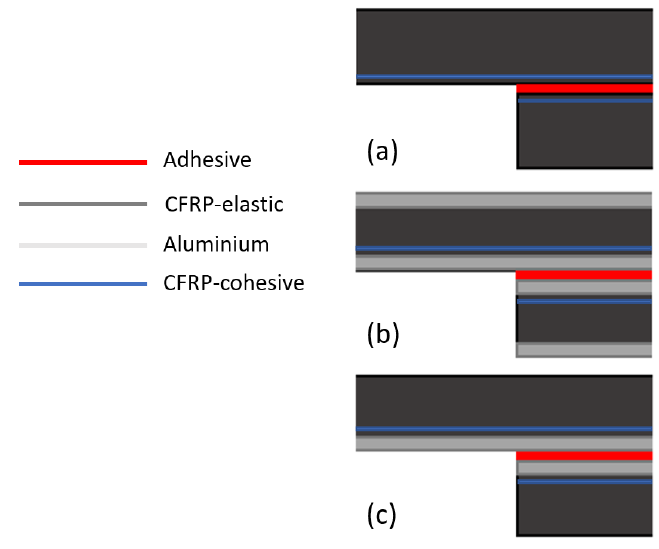
Figure 5. Section assignment for: ( a ) CFRP, ( b ) Al-CFRP-Al, and ( c ) CFRP-Al. The different sections were modelled with elements appropriate to the material being represented, namely: four-node plane stress (CPS4R) elements for the elastic CFRP and four-node plane strain (CPE4R) elements for the aluminium. Cohesive sections were modelled using cohesive elements (COH2D4).